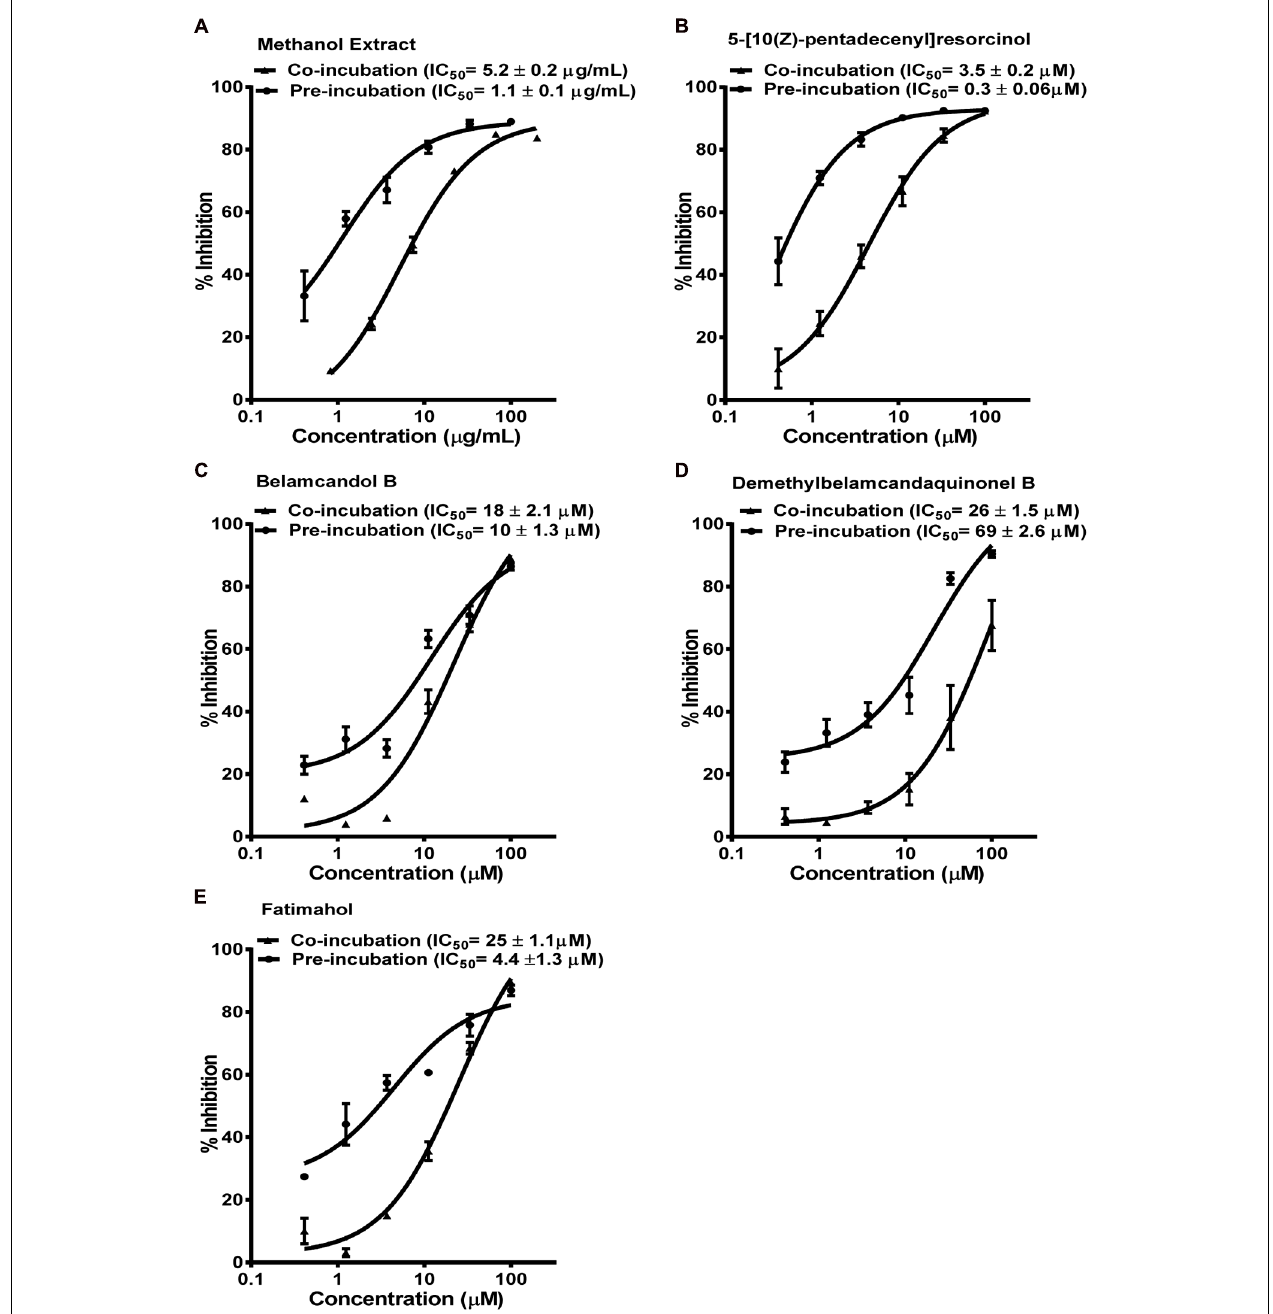
FIGURE 2 | Dose response profiles of reversible and time dependent inhibition (TDI) of CYP3A4 enzyme by Labisia pumila root extract (A) and its alkyl phenolic constituents (B–E). The data are represented as mean ± SD of 3 independent experiments ( n = 2 in each experiment).